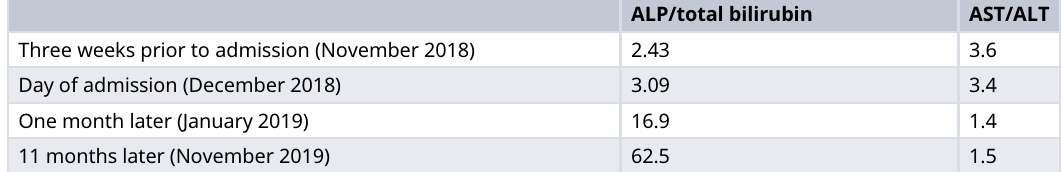
Table 2. Wilson ’ s pattern of liver function tests of the patient before and after treatment. (alkaline phosphatase (ALP), aspartate transaminase (AST), alanine transaminase